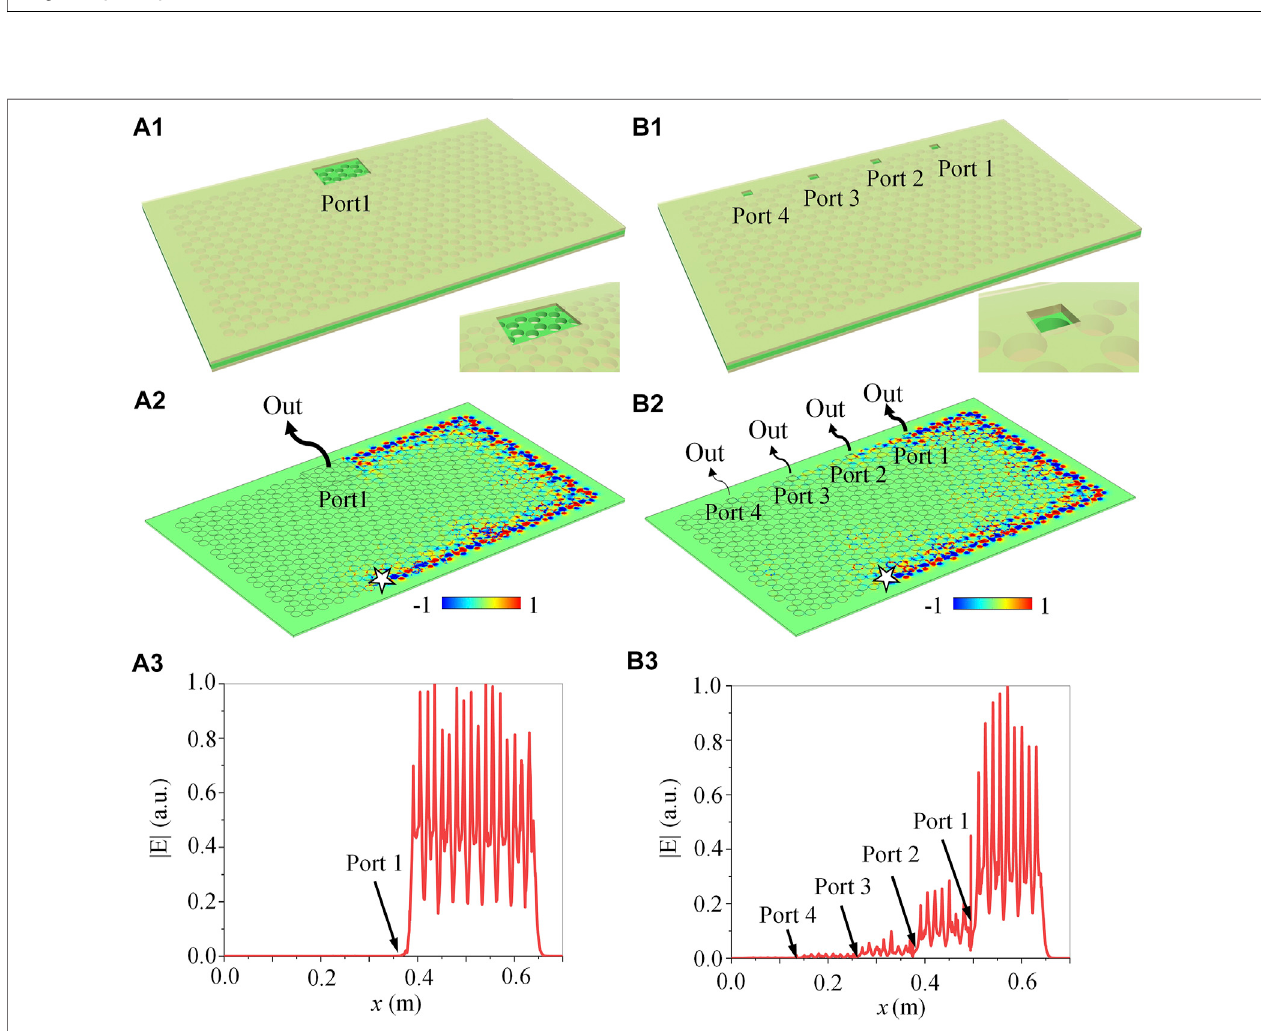
FIGURE 5 | Topological leaky wave antennas. (A) Single port antenna. (B) Four ports antenna. (A1, B1) Oblique-view. (A2, B2) Electric fi eld distribution. (A3, B3) Amplitude of electric fi eld along the upper zigzag interface.